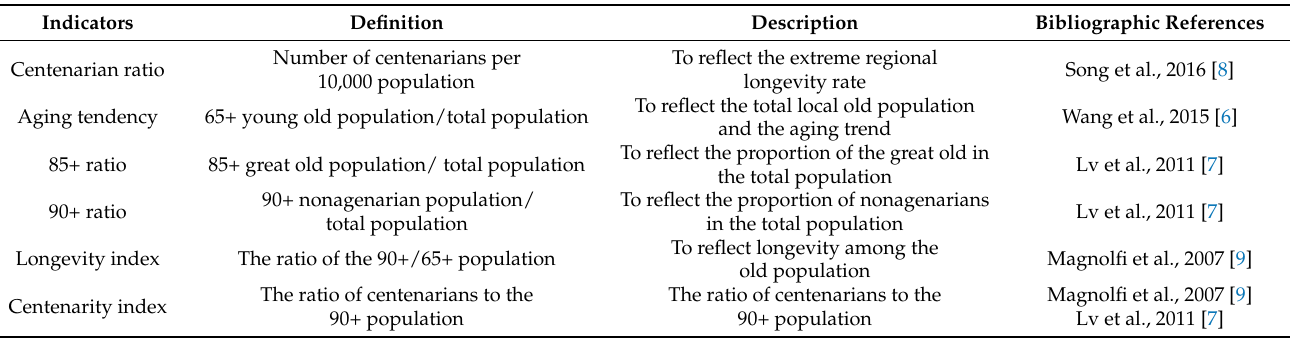
Table 1. Information of the dependent